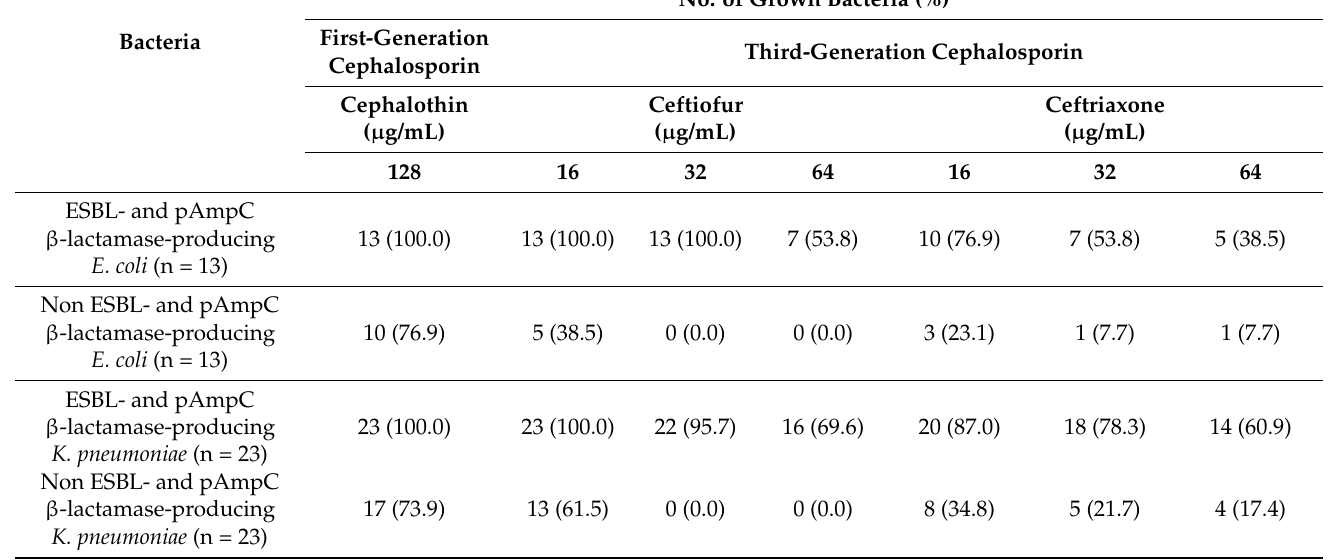
Prevalence of E. coli and K. pneumoniae growth under different concentrations of each